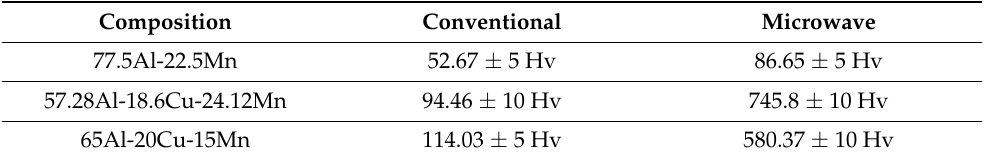
Table 4. Effect of heating mode on Vickers hardness of Al alloy compacts at a 50 gm load for 10 s dwell